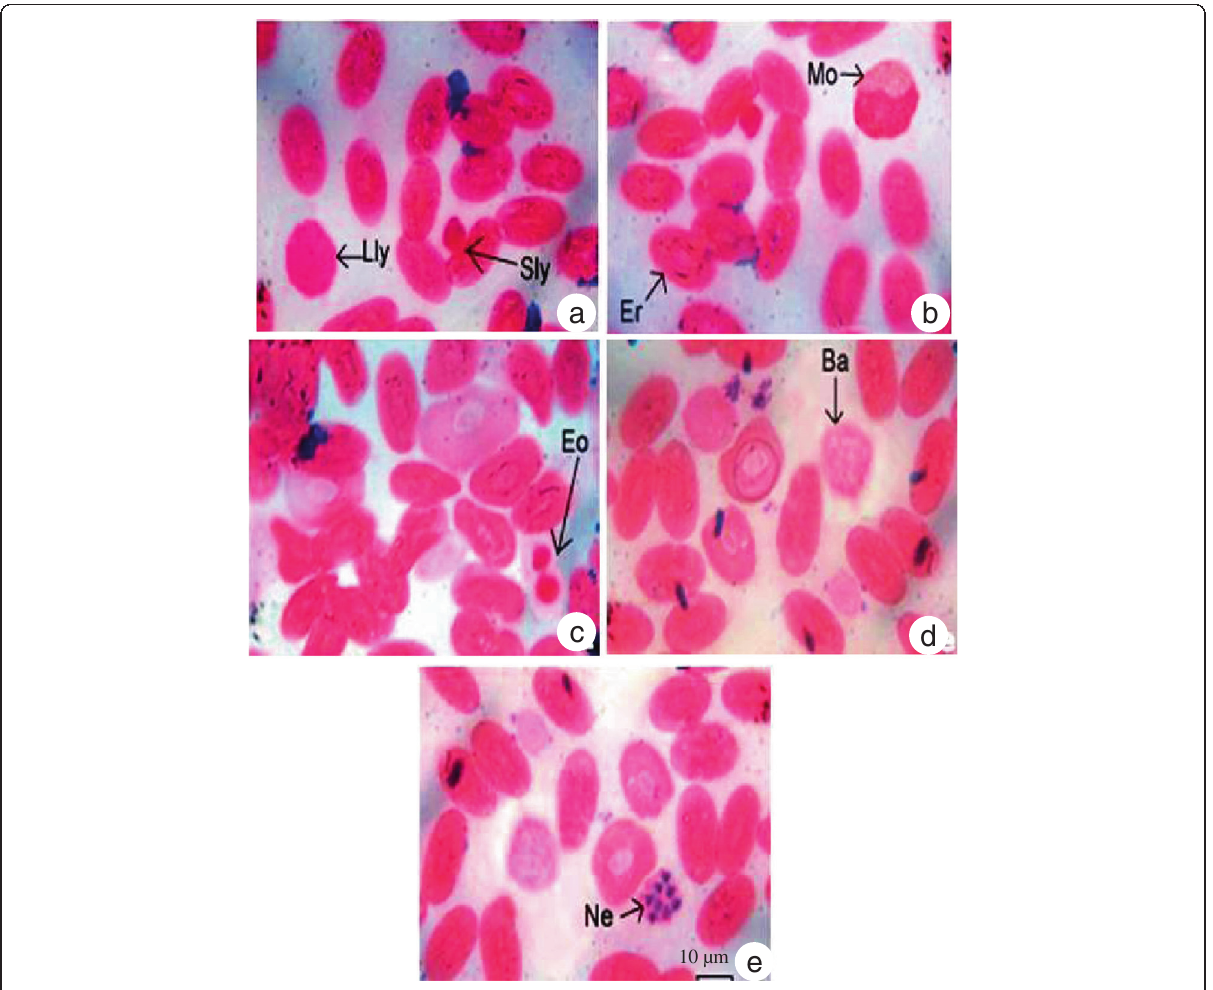
Figure 1 Morphology and staining characteristic of (a) large lymphocytes (Lly), small lymphocytes (Sly), (b) erythrocytes (Er), normocytes (Mo), (c) eosinophils, (d) basophils and (e) heterophils (Ne) of the circulating blood of Naja